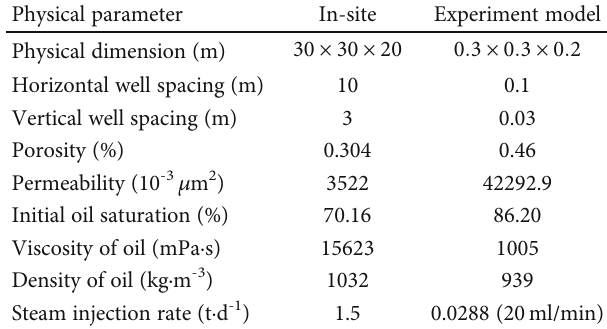
Figure 7: Flow diagram of 2D visualization experiments. Table 2: Parameters of 3D